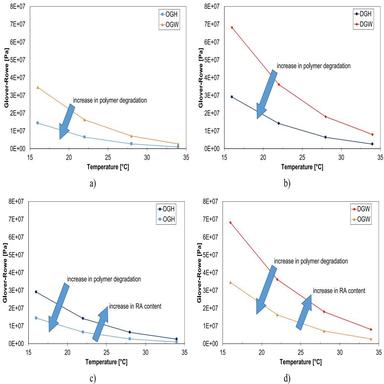
Comparisons between GRP trends elaborated from frequency sweep tests: a), OGH vs. OGW b) DGH vs. DGW extension, c) OGH vs. DGH and d) OGW vs. DGW.